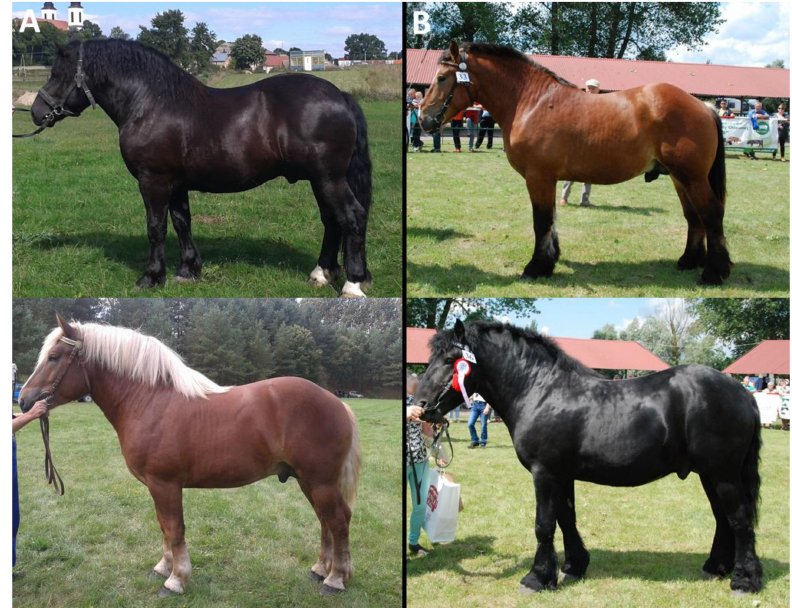
Figure 1. Three years old stallions of ( A ) Sok ó lski and ( B ) Sztumski horses (picture by G. Polak). SNP filtering was performed as previously described [3]. Only genotypes with call rate > 0.97 were used for the analysis. The initial SNP set was filtered to remove markers located on the sex chromosomes and was further reduced by applying population-wide filters. The filters included MAF (minor allele frequency) threshold of 5% and < 20% of missing genotypes in the whole studied population. Additionally, SNPs with critical p -value for Hardy-Weinberg equilibrium (HWE) < 1.0E-06 in each breed separately were excluded. The final SNP panel of 52,023 markers was scattered across the horse genome (EquCab2.0) with an average inter-marker distance of 43.0 kb. The horse types’ genetic di ff erentiation was evaluated using pairwise F ST distances [5] measuring locus-specific allele frequency variation between populations. To detect diversifying selection signatures, SNP-by-SNP F ST values obtained using Plink software v1.90b4 (–fst